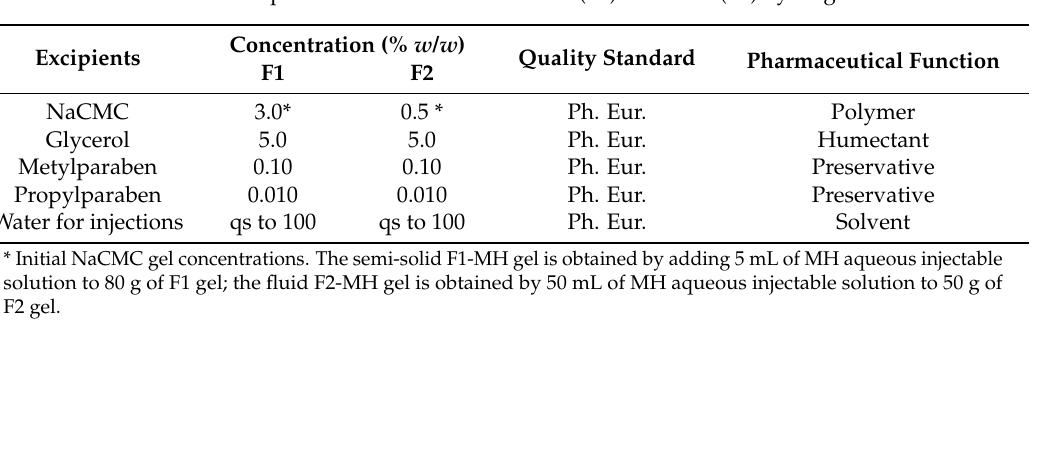
Table 2. Composition of NaCMC semi-solid (F1) and fluid (F2) hydrogels. Excipients Quality Standard Excipients Water for injections